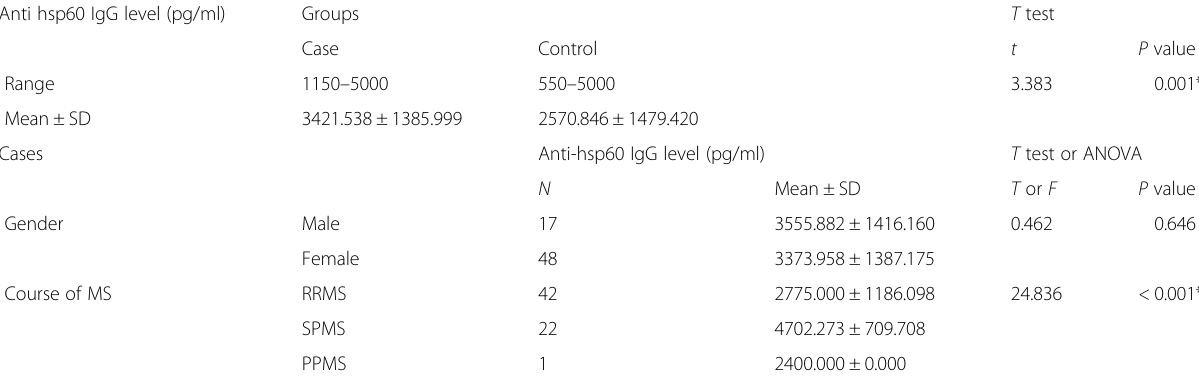
Table 2 Comparison between cases and controls as regard level of anti-Hp hsp60 IgG and its distribution at gender and course of MS